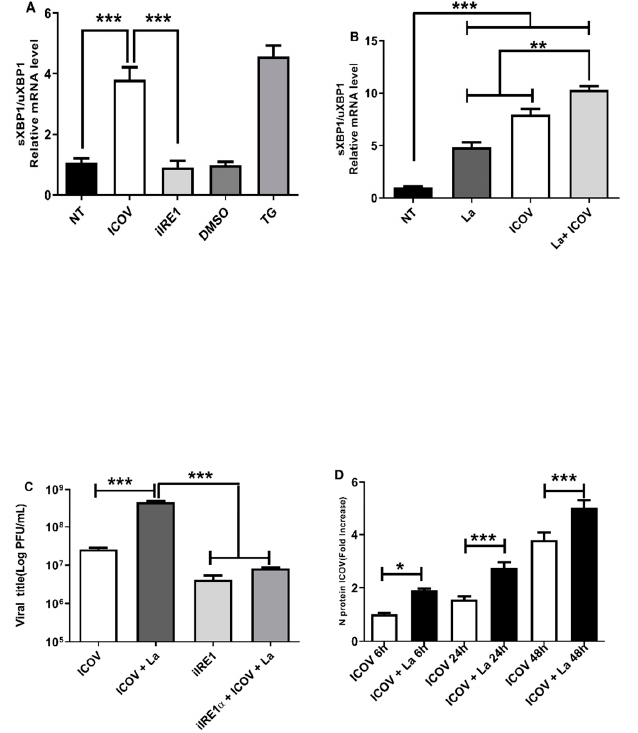
Figure 3. ICOV replication depends on ER stress via and is favored during L. amazonensis coinfection. Peritoneal macrophages from C57BL/6 mice were not treated (NT), infected with Phlebovirus Icoaraci (ICOV) at MOI 1, pre-treated with 100 nM of IRE1 α inhibitor during 1 h followed by ICOV infection or treated with 1 μ M Tapsigargin (TG) or DMSO ( A ). After 6 h, sXBP1 transcript levels were measured by qRT-PCR normalized to uXBP1 transcript levels. The same analysis was done during ICOV/ L. amazonensis coinfection ( B ). The viral title was analyzed through plaque assay ( C ). The mRNA levels of ICOV N protein was verified by qRT-PCR in peritoneal macrophages coinfected with ICOV and L. amazonensis as indicated in the figure ( D ). Asterisks indicate significant differences with * p < 0.01, ** p < 0.001 or *** p < 0.0001.